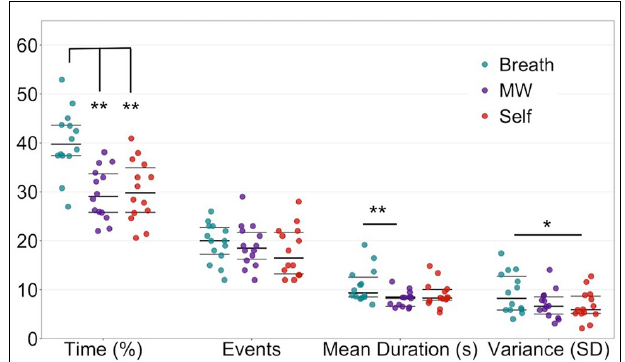
FIGURE 5 | EMBODY Step 3: quantification and mental state profiles of internal attention during meditation. Based on the estimate of mental states and event specification from Step 2, metrics of attention during breath meditation were quantified for each mental state and initially characterized at the group level: percentage time spent in each mental state (Breath, MW, or Self), the number of events, mean duration of events (s), and variability (standard deviation or SD) of the duration of events. Overall, participants spent more time attending to the breath vs. MW or self-referential processing. Beeswarm plots present each data point, the median (bold black line), and ± 25th percentile range (gray lines). See Supplementary Table S7 for full metric statistics. *paired t (13) = 2.46, p = 0.029, after one-way ANOVA F (2,12) = 4.20, p = 0.026. **paired t s (13) ≥ 3.18, p s ≤ 0.007, after one-way ANOVA F s (2,12) ≥ 6.47, p s ≤